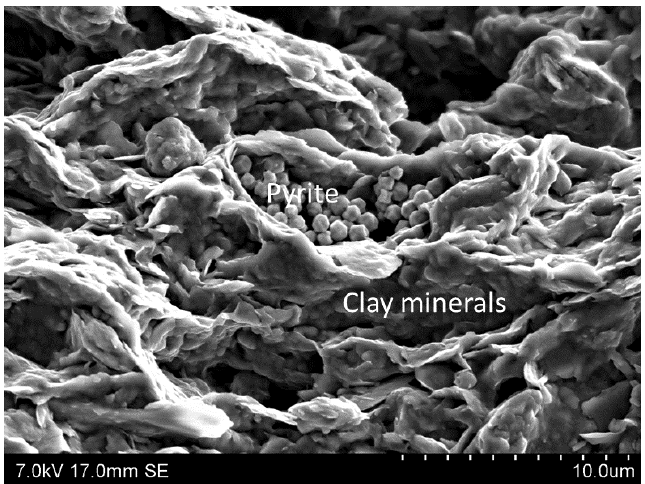
Figure 1. Scanning electron microscope (SEM) image of a typical North Sea shale sample.